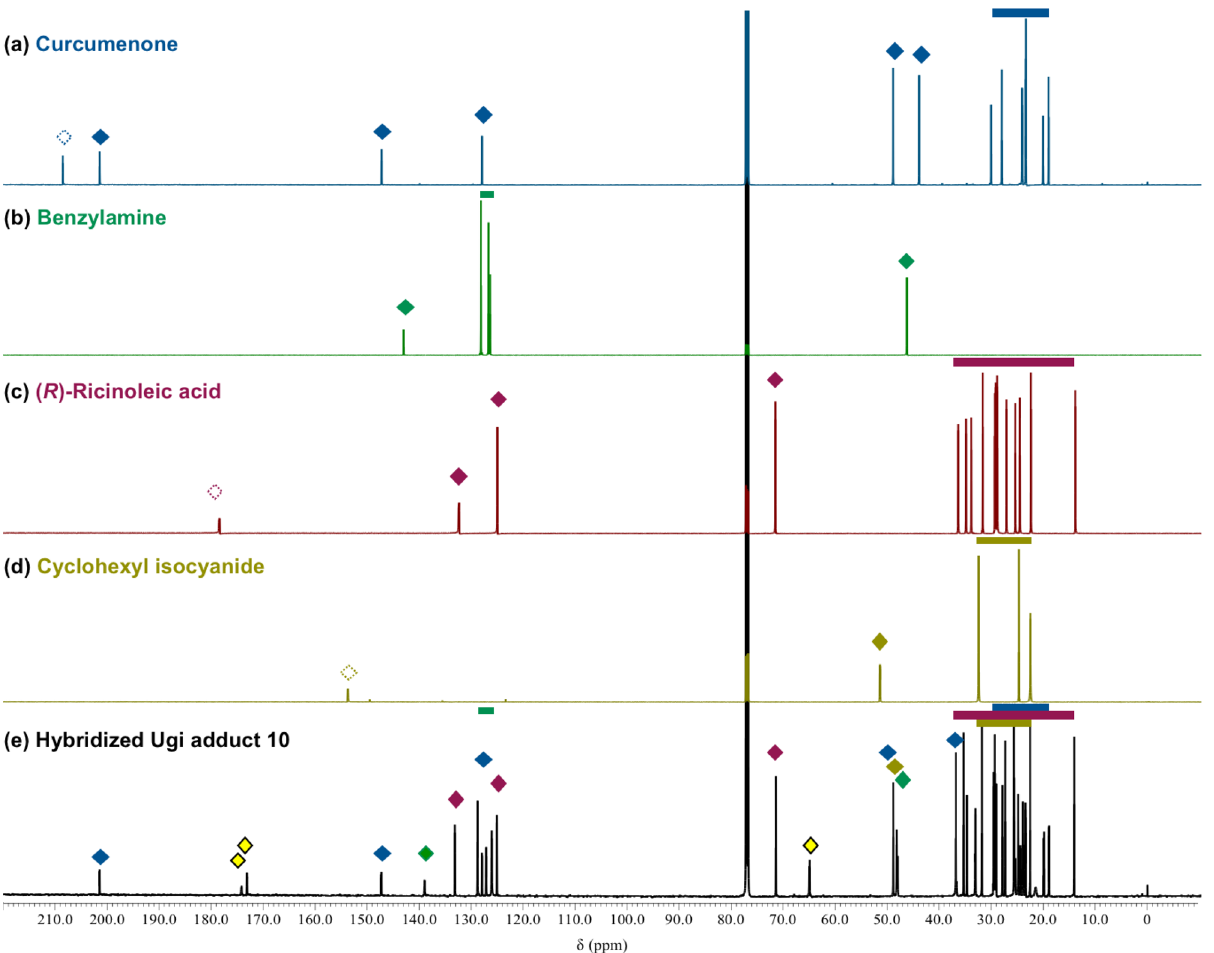
Figure 6. 13 C NMR spectra (151 MHz) of ( a ) curcumenone, ( b ) benzylamine, ( c ) ricinoleic acid, ( d ) cyclohexyl isocyanide, and ( e ) hybridized Ugi adduct 10 in CDCl 3 . Units of chemical shift (δ) are ppm relative to residual chloroform (77.16 ppm) as an internal